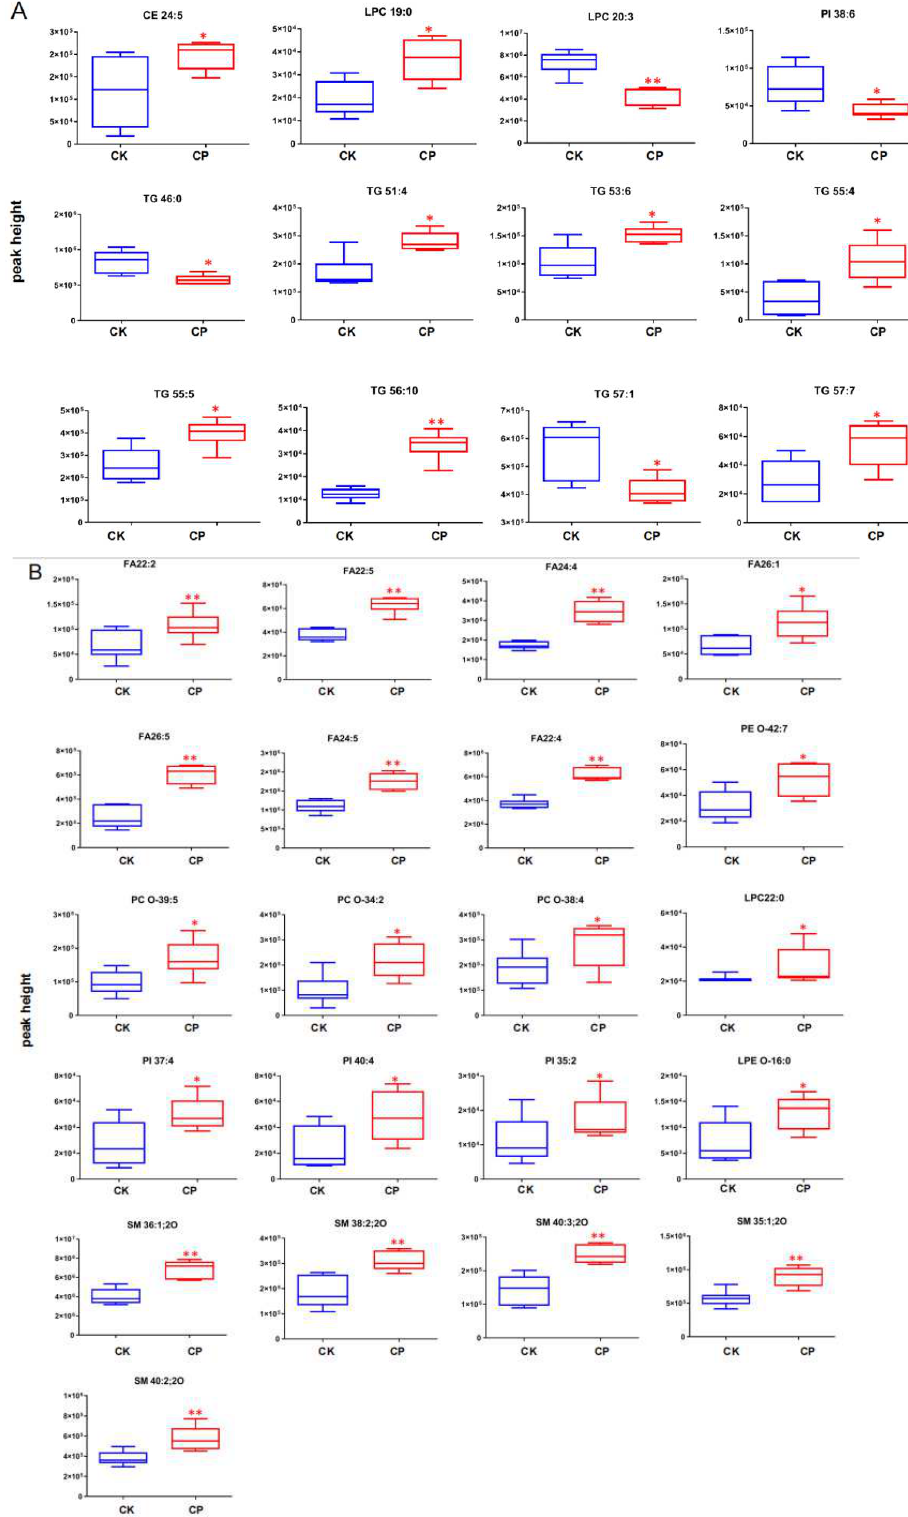
Figure 5. Normalized peak intensity of amniotic fluid lipids after CP treatment ( n = 6). ( A ) Positive ion mode; ( B ) negative ion mode. n = 6. Each data point represents the mean ± S.E.M. * p < 0.05 and ** p < 0.01, versus CK.